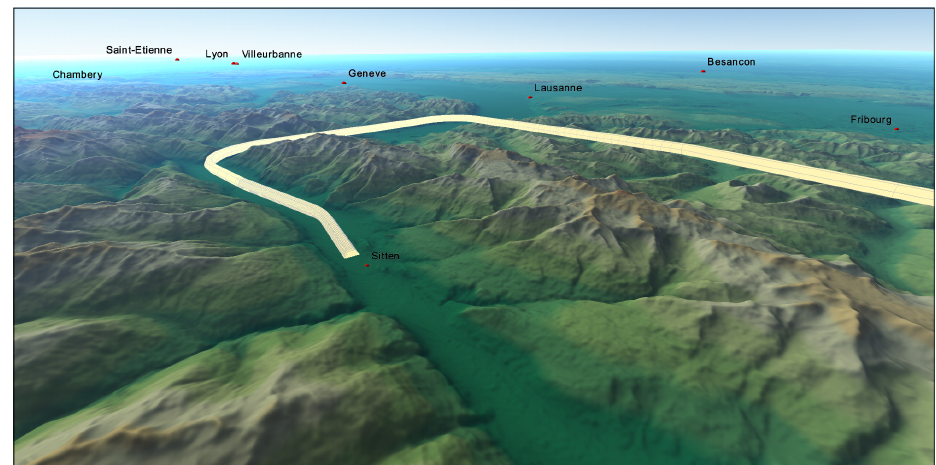
Figure 10. Visualization of an approach trajectory to the airport of Sion, Switzerland. The trajectory is depicted as a hexagonal tube.